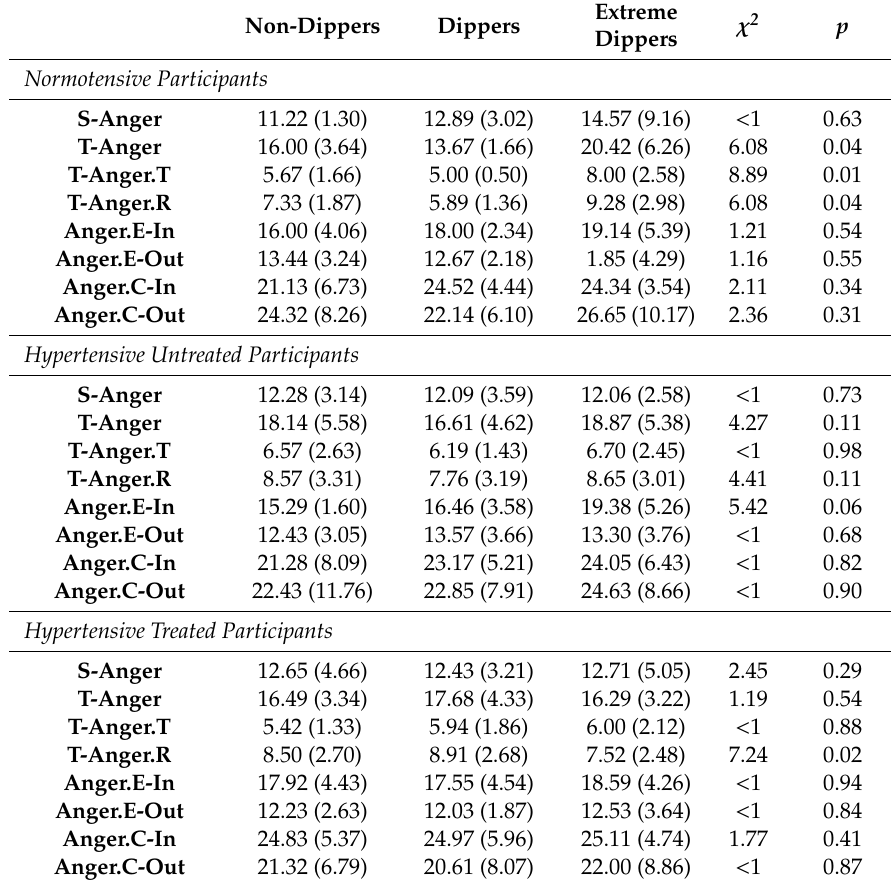
Table 4. Means of anger scores and χ 2 results for Non-Dippers, Dippers, and Extreme Dippers in the three groups of Normotensive, Untreated, and Treated Hypertensive participants.